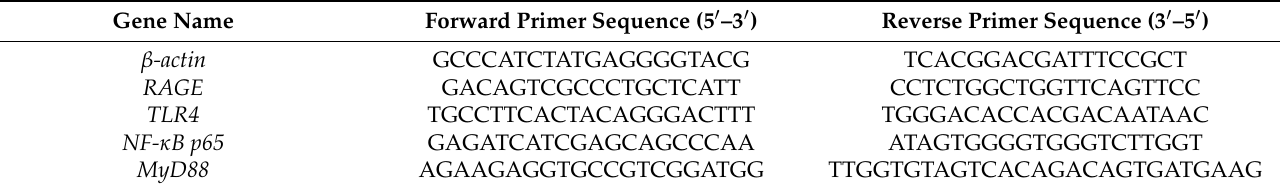
Table 2. The primer sequence of genes for Real-Time